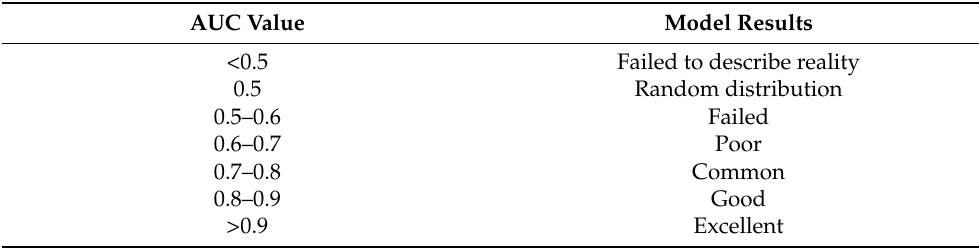
Table 3. The AUC values for our model accuracy